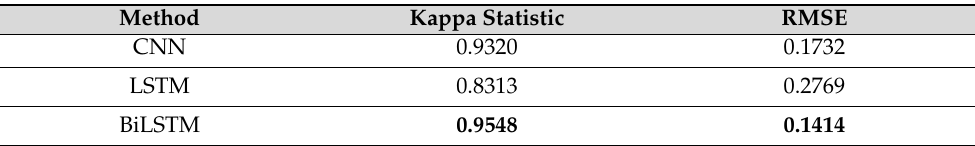
Table 13. Kappa statistics and RMSE values of deep learning algorithms on cancer stage classification with all attributes. (Illustrations by the